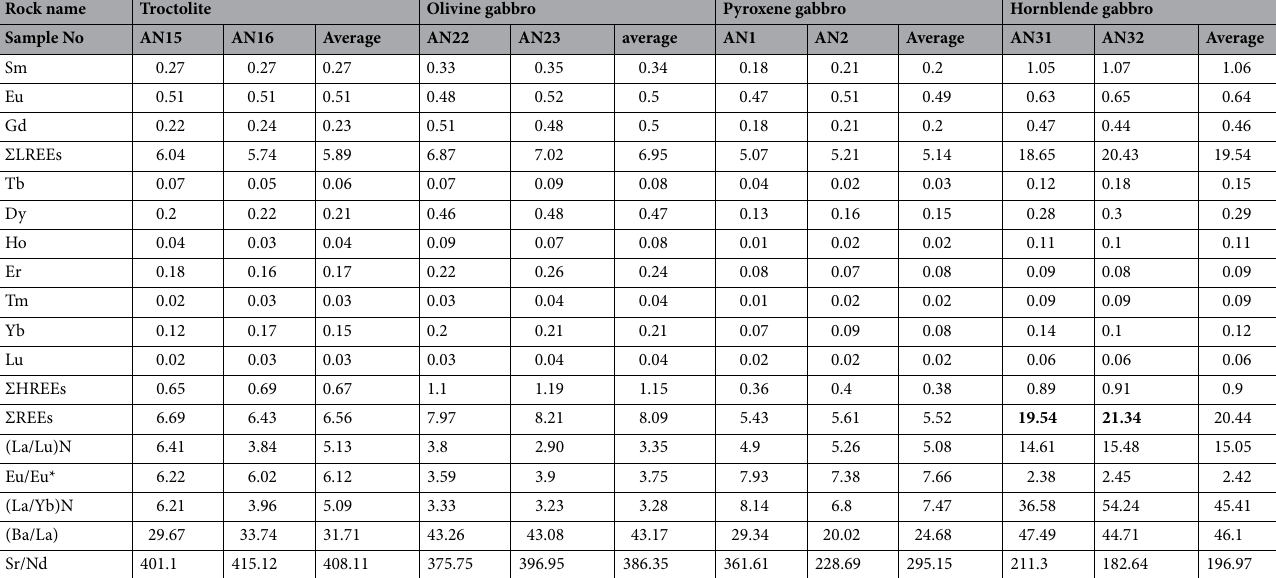
Table 2. Whole-rock major (wt %), trace and rare earth elements (ppm) of Akab El-Negum mafic rocks. Significant values are in [bold].